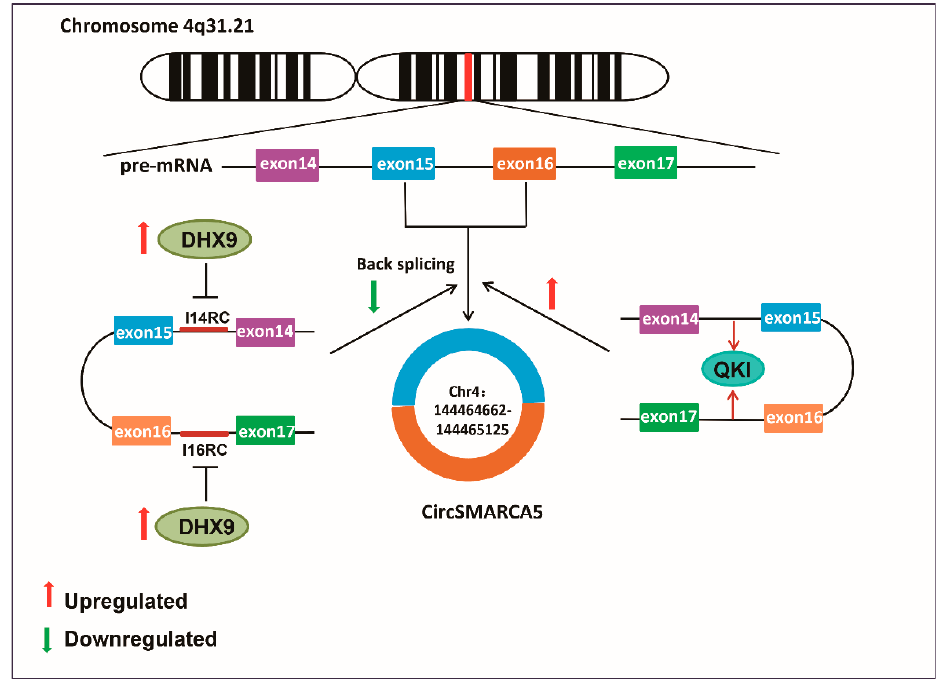
Figure 1. Biogenesis and upstream regulation mechanisms of circSMARCA5. CircSMARCA5 is located on Chromosome 4q31.21 and derived from exon 15 and exon 16 of the SMARCA5 gene, containing 464 nucleotides (chr4:144464662-144465125). I14RC (the reverse complement sequence in intron 14) and I16RC (the reverse complement sequence in intron 16) of the mRNA of SMARCA5 precursor have the action target of ExH-box helicase 9(DHX9), and the upregulation of DHX9 inhibits the production of circSMARCA5. KH domain containing RNA binding (QKI) combines upstream and downstream exon 15 and exon 16 at the site of circSMARCA5 formation on the mRNA of the SMARCA5 precursor to promote circSMARCA5 formation in the tumor.